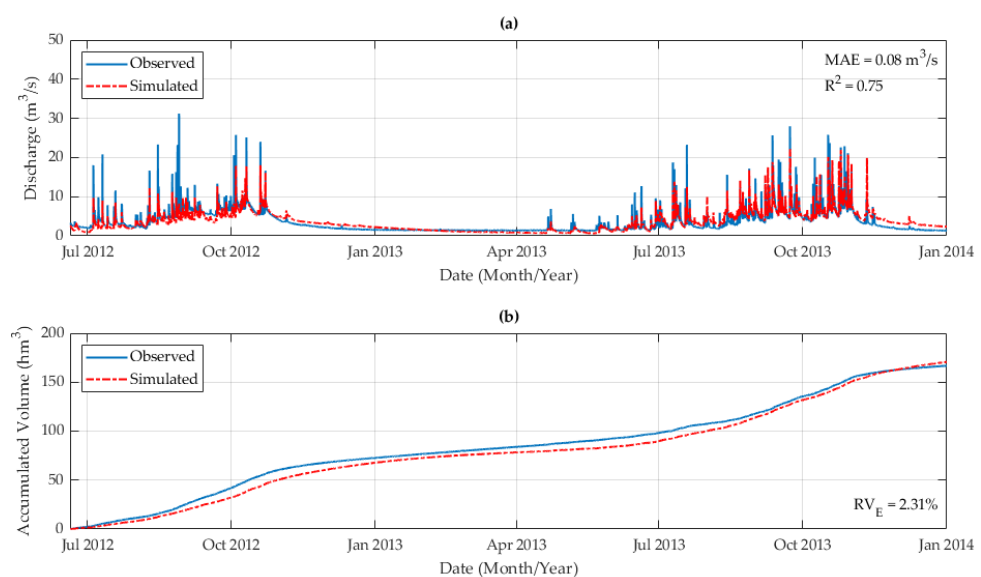
discharge in the calibration dataset.